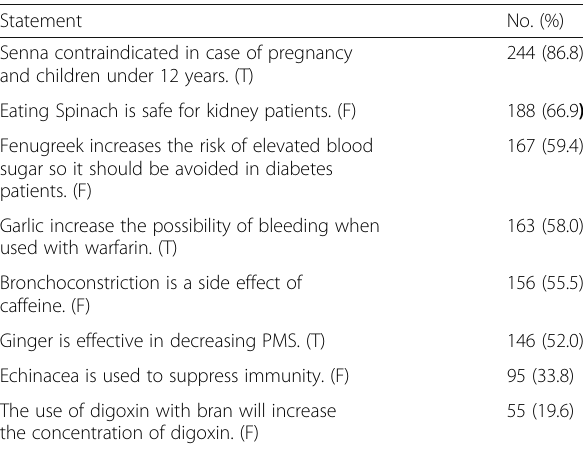
Table 6 Frequencies and percentages of participant pharmacists